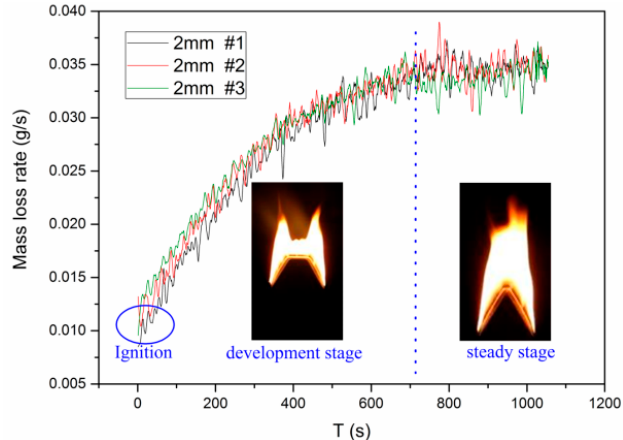
Figure 2. Mass loss rate histories and recorded flame profiles for 2 mm sample in 102 kPa. The flame spread process is divided into three stages: (1) ignition stage; (2) development stage; (3) steady-state stage.